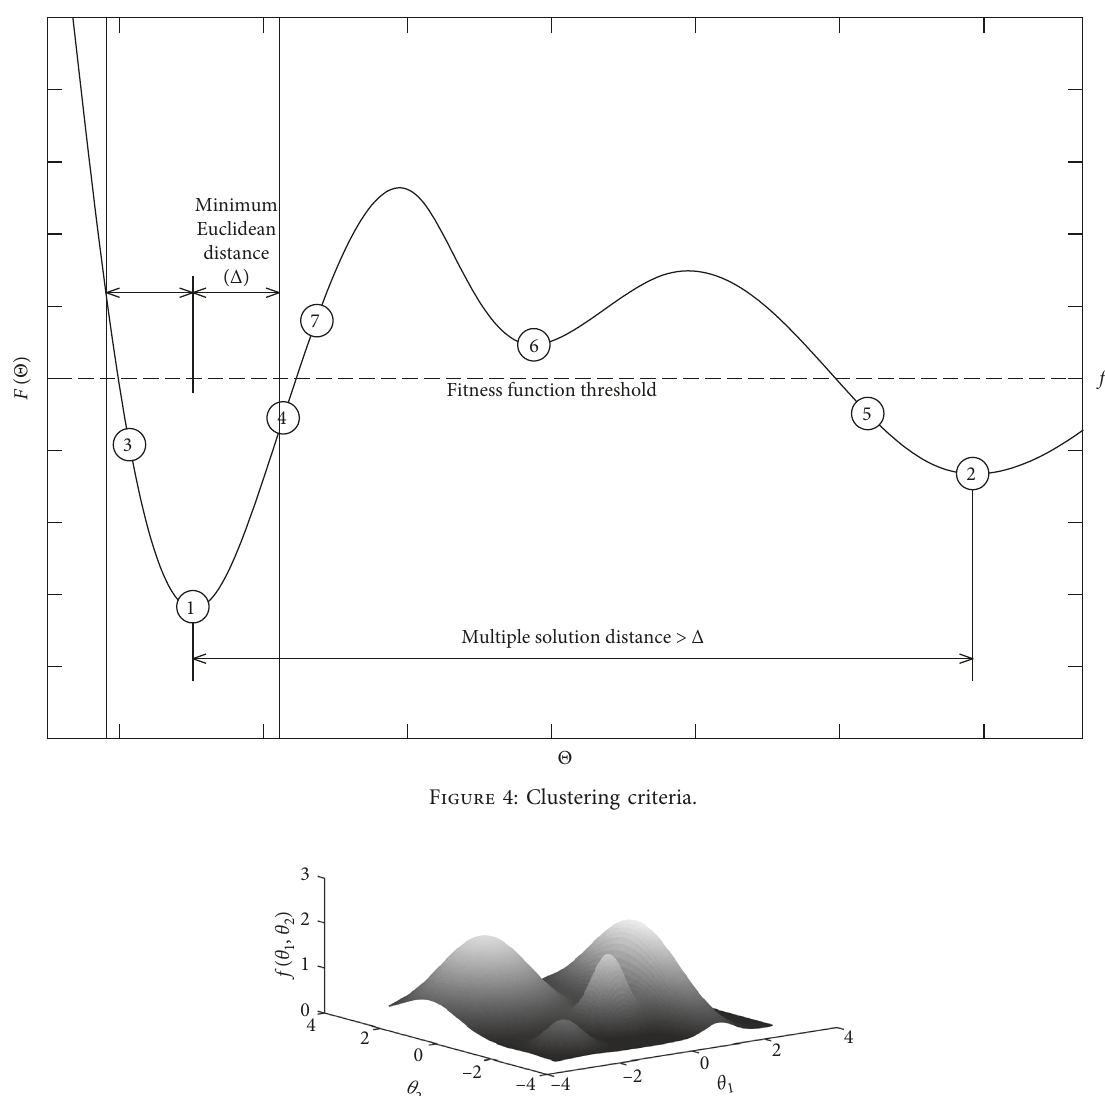
Figure 5: Surface plot for 2 parameters.